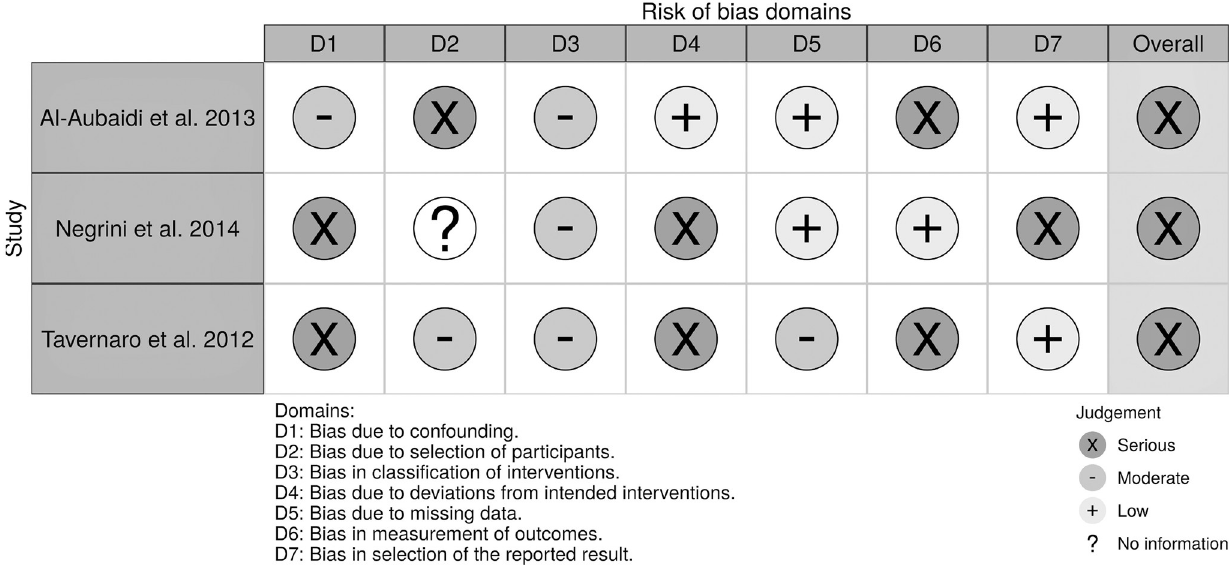
Fig 3. Judgement of risk of bias which was assessed using the Risk OF Bias in Non-randomized Studies-of Interventions (ROBINS-I) tool for observational studies.